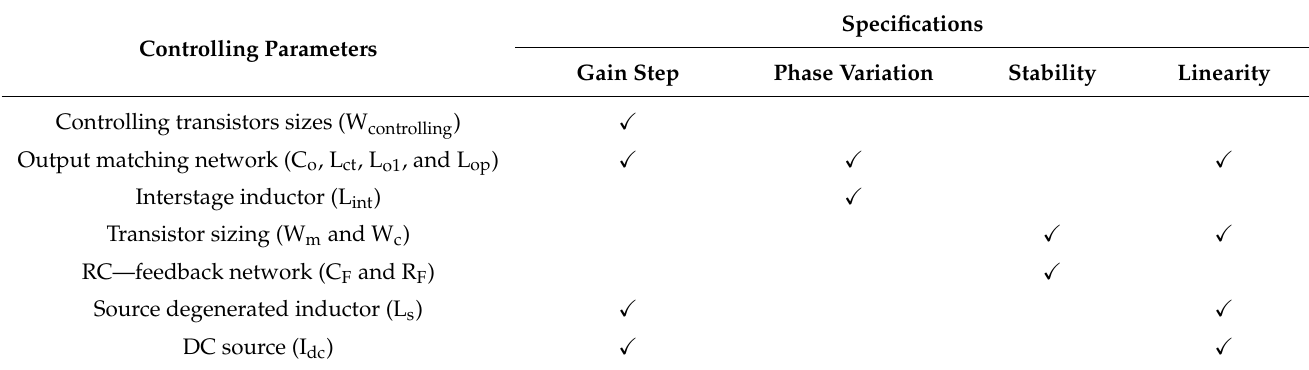
Table 1. Specifications and the corresponding parameters in the control.